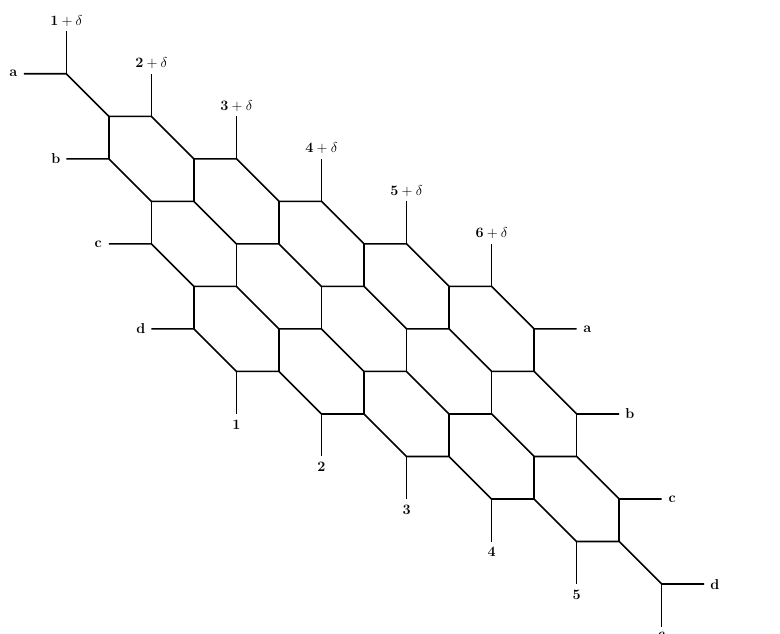
Figure 19 . Toric web diagram with ( N; M ) = (6 ; 4) and shift (cid:14)